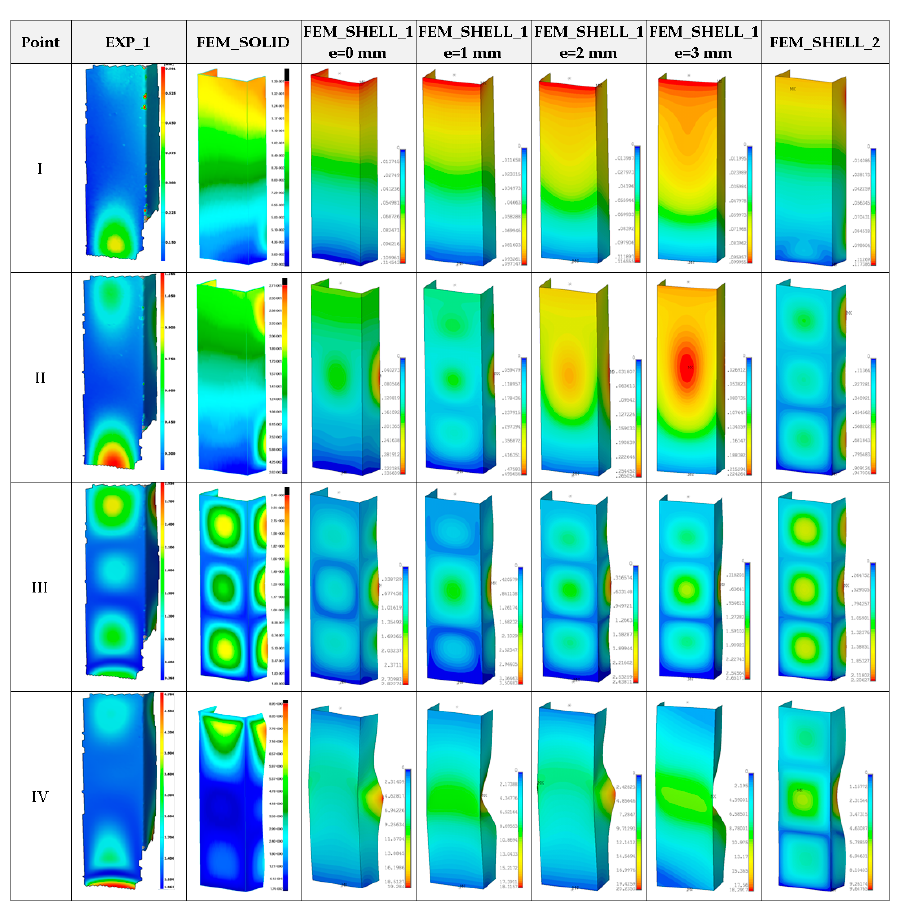
Figure 11. Deformation maps of columns at ambient temperature.